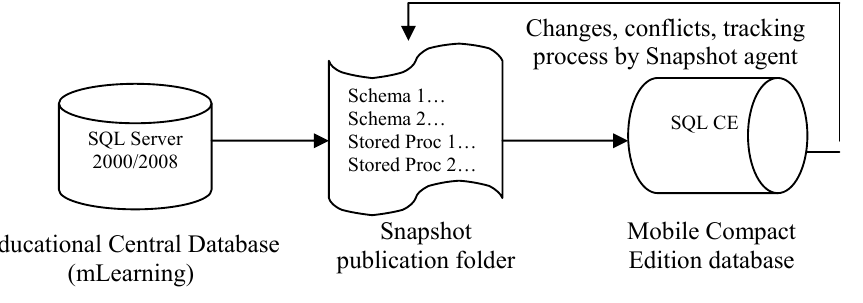
Figure 3: Snapshot Publication